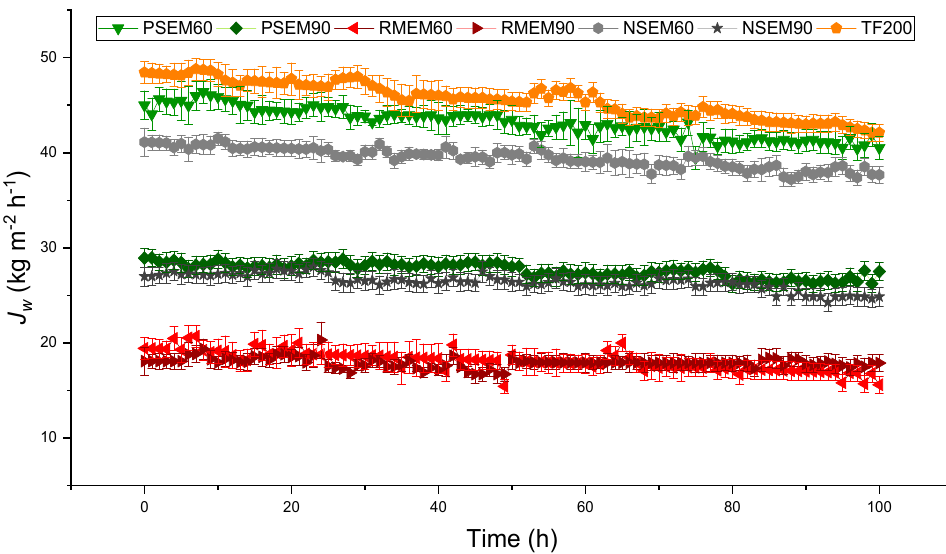
Figure 8. Long-term DCMD regenerative test of the unsupported (NSEM60, NSEM90), and the supported electrospun nanofibrous membranes (PSEM60, PSEM90, RMEM60, RMEM90) and the commercial membrane TF200). Experimental conditions: T f = 80 °C, T p = 20 °C, A m = 1.26 × 10 − 3 m 2 , feed and permeate flow rate fixed at 0.8 L min − 1 , C f at 65 g L − 1 and distilled water as permeate.